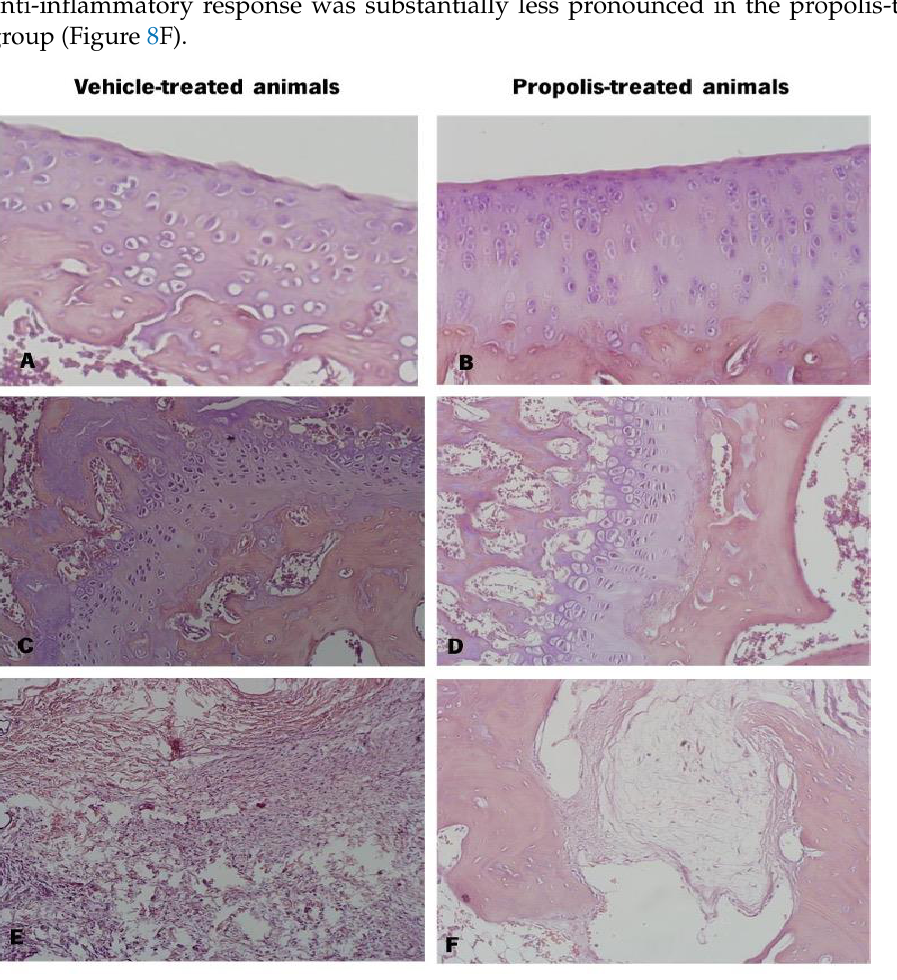
Figure 8. Histology of the knee joint of vehicle and propolis-treated animals stained with hematoxylin-eosin. ( A ) Knee joint cartilage with surface erosion and altered chondrocytes arrangement; ( B ) Knee joint cartilage with organized chondrocytes columns; ( C ) Alveolar bone with thickening of the epiphyseal line and trabeculae; ( D ) Alveolar bone; ( E ) Periarticular tissues with oedema and high level of inflammatory response; ( F ) Periarticular tissue with oedema and less pronounced inflammatory response.